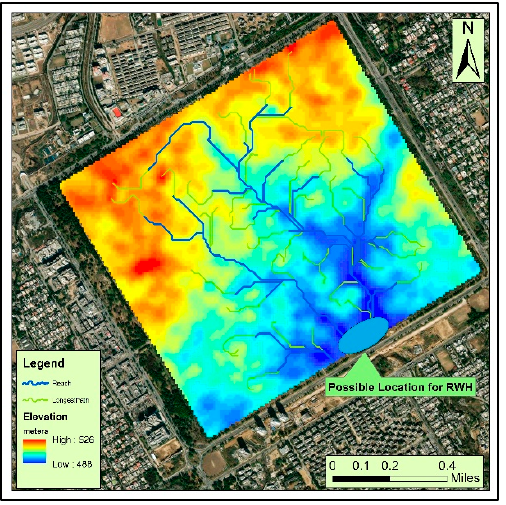
Figure 2. Showing possible location for RWH, reaches, longest flow paths, and elevations.